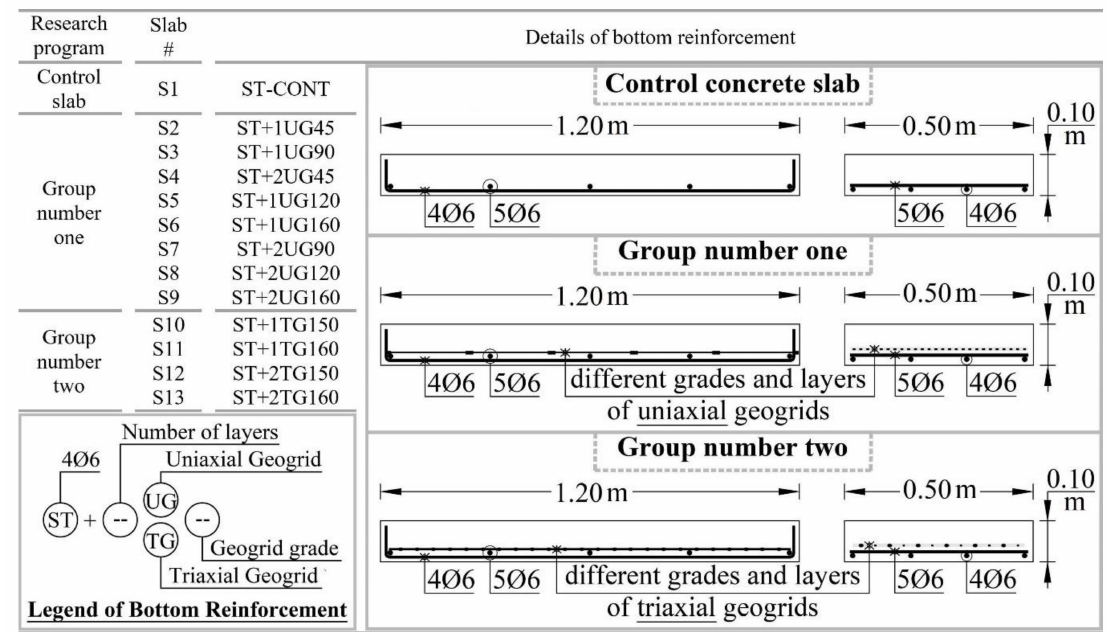
Figure 2. General reinforcement details per each group and specific reinforcement details per each concrete